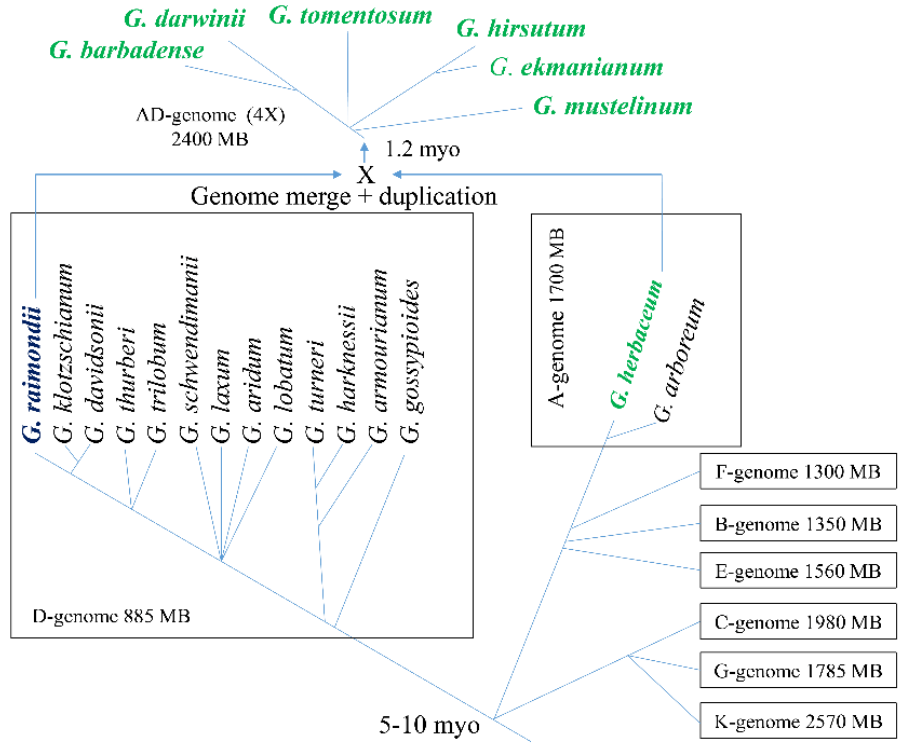
Figure 1. The evolution of Gossypium genus and the formation of tetraploid Gossypium species. MB show genome size of representative species.